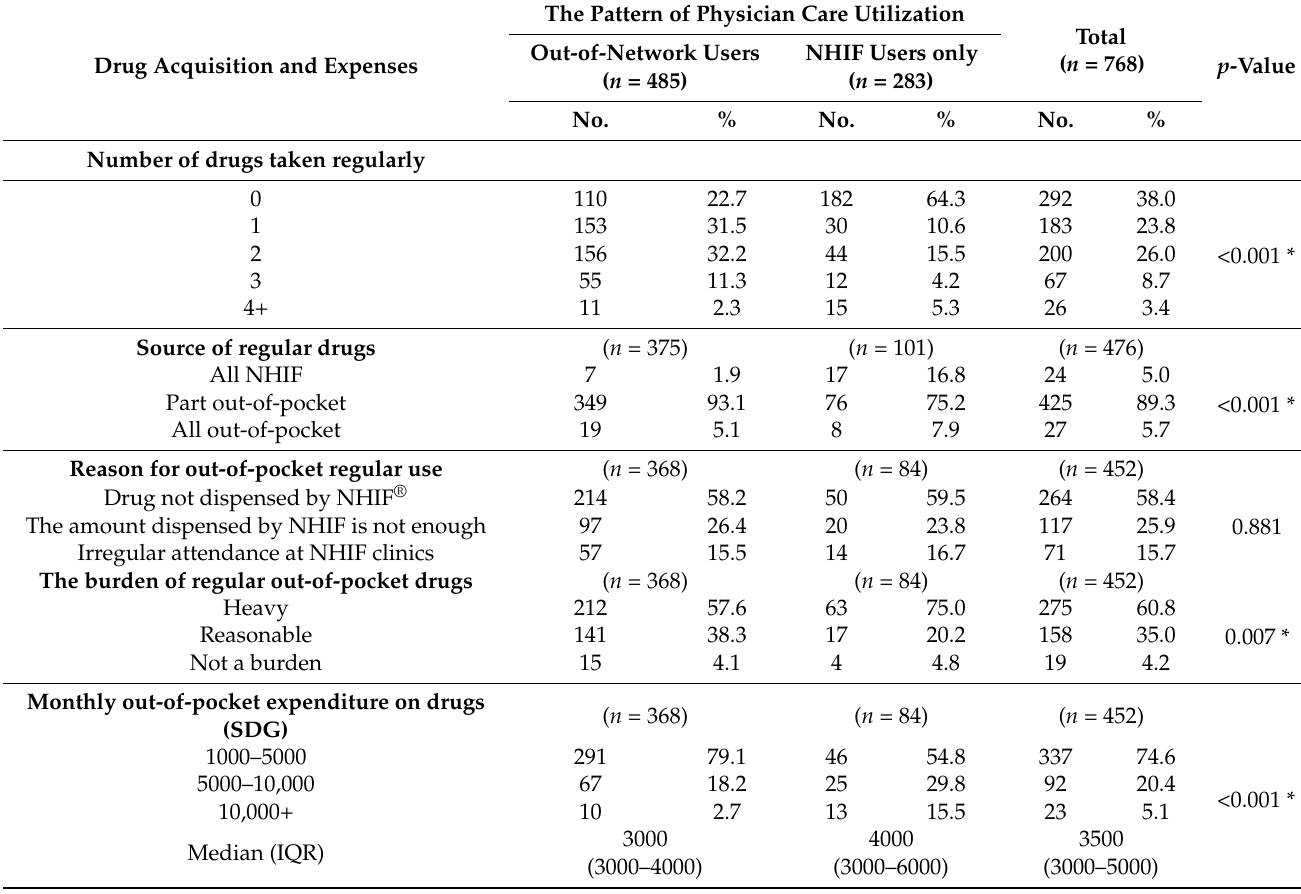
Table 2. Association of the pattern of physician care utilization with drug acquisition and